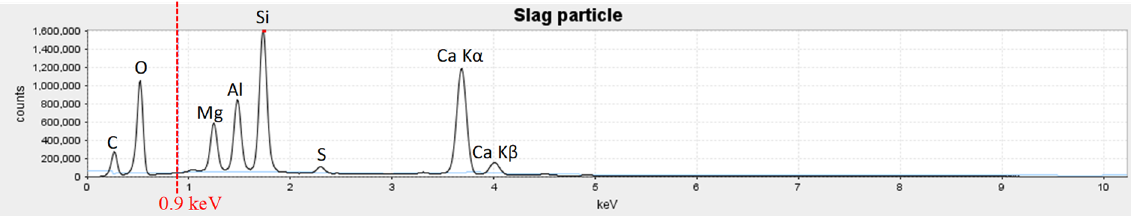
Figure 8. PARC sum spectrum for a GBFS particle (purple coloured in the PARC map, Figure 9), indicating the presence of Mg, Al, Si, S, and Ca by their characteristic X-ray lines.